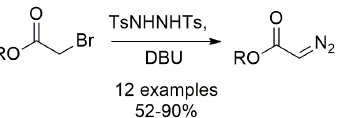
Figure 39 - Synthesis of diazo compounds from bromoacetates.